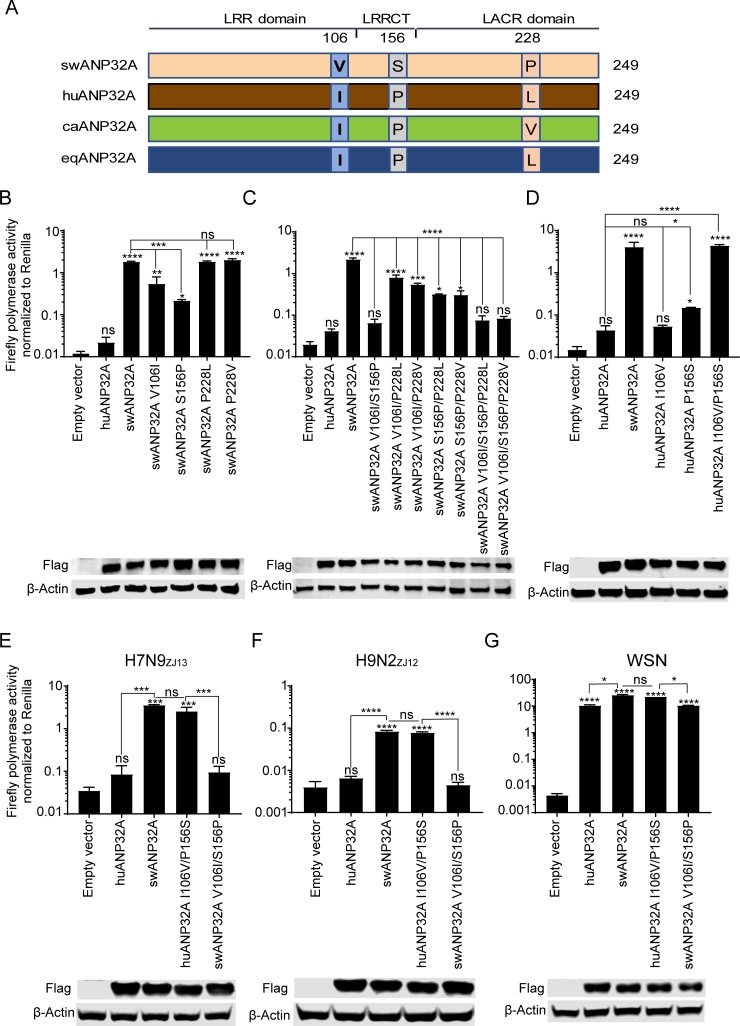
Mapping the unique sites of swANP32A responsible for the support for avian influenza viral replication.(A) Schematic of alignment from mammalian ANP32A amino acid sequences including human ANP32A (huANP32A), canine ANP32A (caANP32A), equine ANP32A (eqANP32A) and swine ANP32A (swANP32A). Three residues were annotated as there are mutations on swANP32A, at positions 106, 156, and 228. (B, C) The mutants of swANP32A were constructed by overlapping PCR. DKO cells were co-transfected with expression plasmids carrying PB1 (40 ng), PB2 (40 ng), PA (20 ng) and NP (80 ng) from H7N9ZJ13, together with 40 ng minigenome reporter and 10 ng Renilla luciferase expression plasmids (pRL-TK, as an internal control) in the presence of swANP32A or its mutants or empty vector. Cells were then lysed using passive lysis buffer and luciferase activity was measured at 24 h post transfection. (D) The mutants of huANP32A were co-transfected into DKO cells together with polymerase plasmids from H7N9ZJ13, plus a minigenome reporter and a Renilla luciferase control. Luciferase activity was analyzed as described above. (E to G) The mutants of huANP32A or swANP32A were co-transfected together with plasmids carrying the polymerases from H7N9ZJ13 (E), H9N2ZJ12 (F), or WSN (G). Luciferase activity was analyzed as described above. (B to G, data are Firefly activity normalized to Renilla. Statistical differences between cells are labeled according to a one-way ANOVA followed by a Dunnett’s test; NS = not significant, *P<0.05, **P < 0.01, ***P < 0.001, ****P < 0.0001).